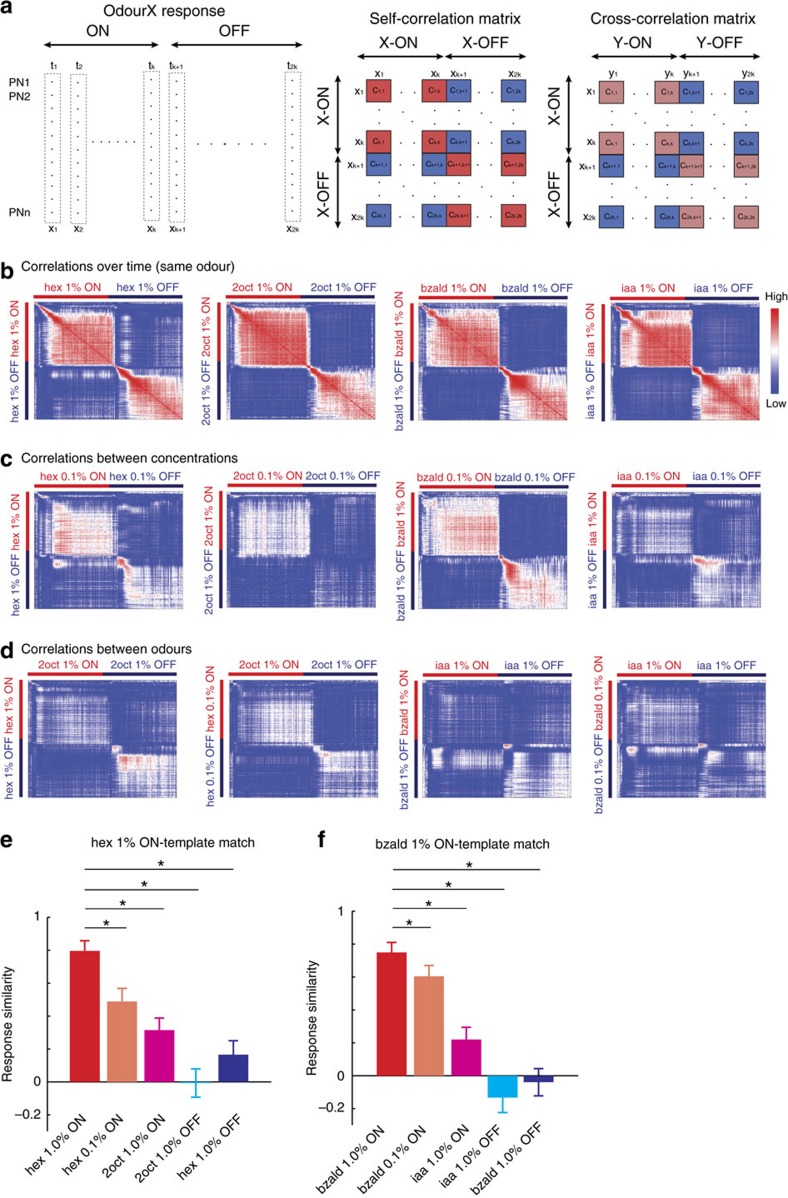
ON versus OFF response similarities.(a) Schematic overview of the analysis approach. Each rectangular column indicates population neuron response vector in a 50 ms time bin. Right, self- and cross correlations between response vectors in different time bins were computed and shown as a colour-coded image. (b) Correlations between ensemble response vectors evoked by an odorant in different time bins following stimulus onset is shown. The 4 s stimulus ON and 4 s stimulus OFF periods are identified using red and blue bars along the axes. Spike counts were averaged across trials (n=25 trials) and used for this analysis. Note that each pixel represents correlation between one ensemble vector with another. Similarly, one row or column represents the correlation between one ensemble vector with all other vectors in the identified time periods (80 ON response vectors and 80 OFF response vectors). The colour scheme used for representing the correlation values is shown on the right; cooler colours indicate lower correlations; hotter colours represent higher correlations. In general, the diagonal blocks tended to have higher correlations (more red pixels), whereas the off diagonal blocks had pixels mostly of lower correlations (i.e. more blue pixels). (c) Similar correlation plots but comparing the ON and OFF response vectors of different concentrations of the same odorants are shown. Comparisons were made between 1% and 0.1% dilutions of the following four odorants: hexanol (hex), 2-octanol (2oct), isoamyl acetate (iaa), and benzaldehyde (bzald). (d) Cross-correlations between different odorants are shown. Comparisons were made between the following four odour pairs: hex 1% and 2oct 1%, hex 0.1% and 2oct 1%, bzald 1% and iaa 1%, and bzald 0.1% and iaa 1%. (e) A comparison of response similarity (see Methods) between ON and OFF response segments of the same and different odorants are shown. Similarity with respect to hex 1% ON template is shown (mean±s.d.). Asterisks indicate significant change in similarity (*P<0.05, paired t-tests with Bonferroni correction for multiple comparisons, n=25 trials). (f) Similar plots are shown but now comparing the response similarity with respect to the bzald 1% ON template.